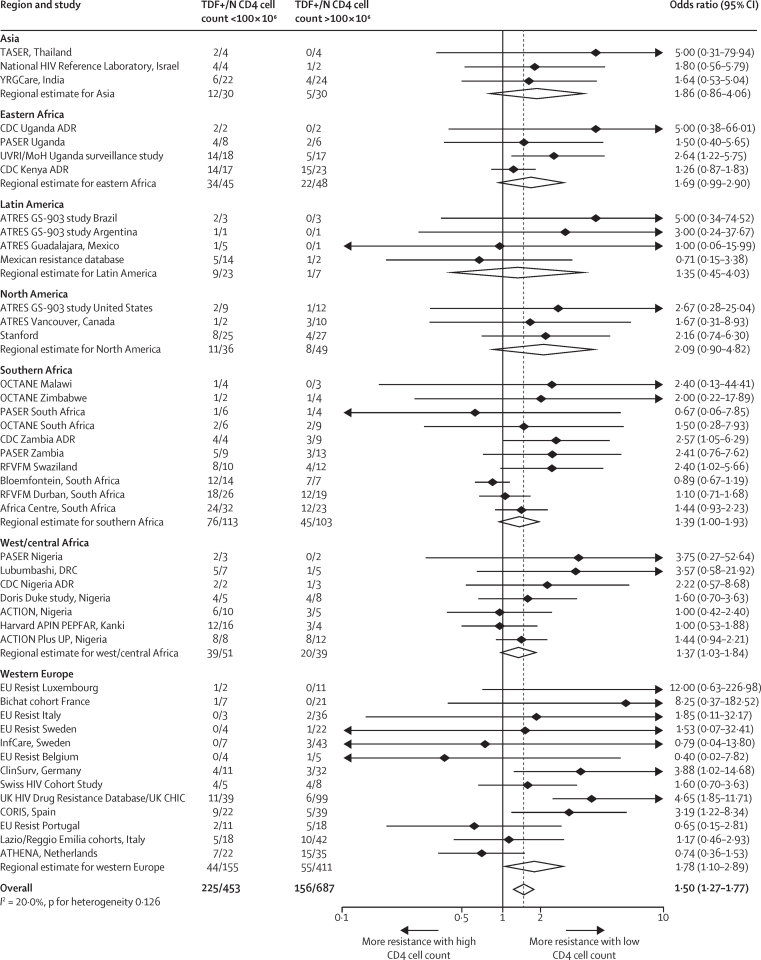
Pooled odds ratios for tenofovir resistance after viral failure for baseline CD4 cell count <100 vs ≥100 × 106 cells per μLTDF+ denotes presence of tenofovir resistance. TDF=tenofovir disoproxil fumarate.